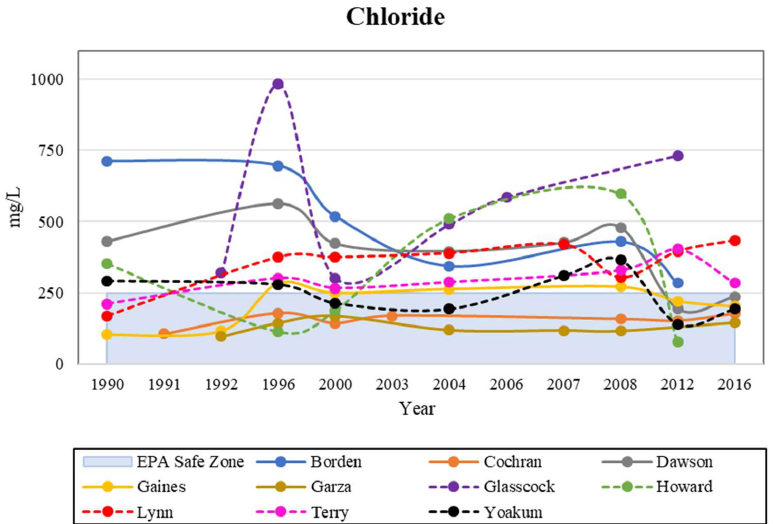
Figure 4. Historical analysis of chloride levels in the study area, compared with the EPA safe zone.